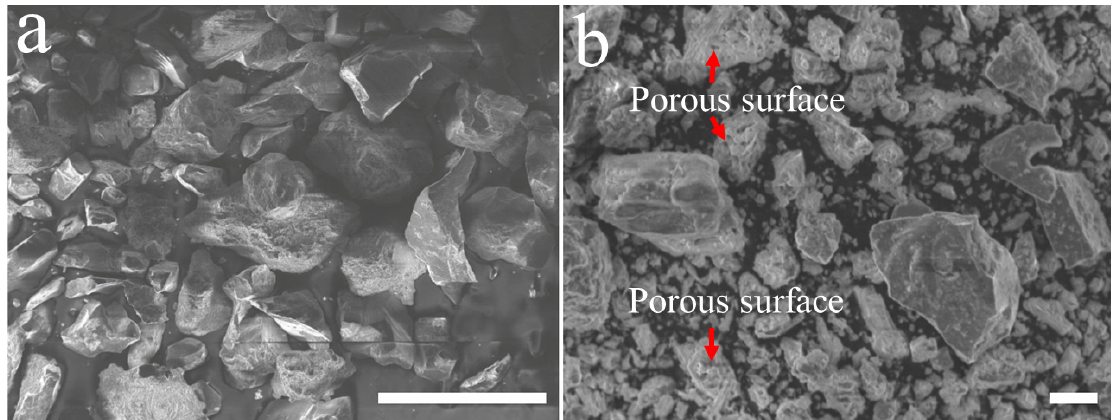
Table 1. Chemical analysis of the concentrated and screened sulfide gold sample <45 μ m (Au*, Ag*: ppm).